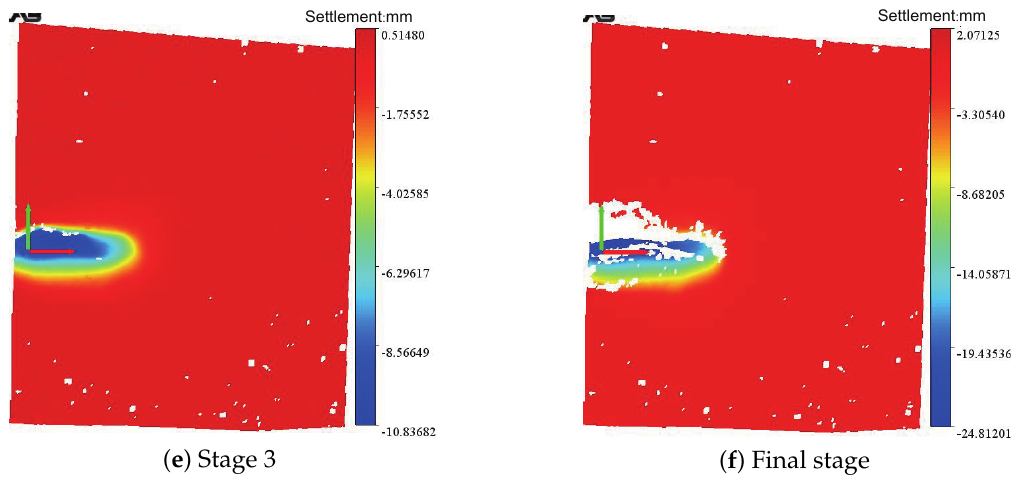
Figure 10. 3D maps of the surface settlement without the pipe roof, C / D = 1.